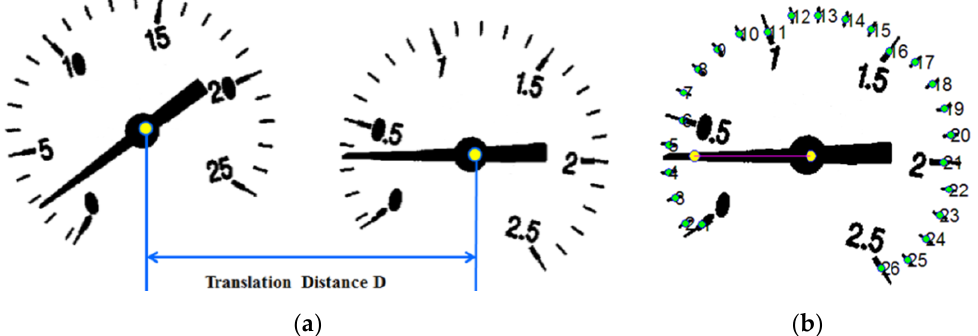
Figure 8. ( a ) Translation distance between two pointer meters; ( b ) result of critical points of the meter on the right in the image.